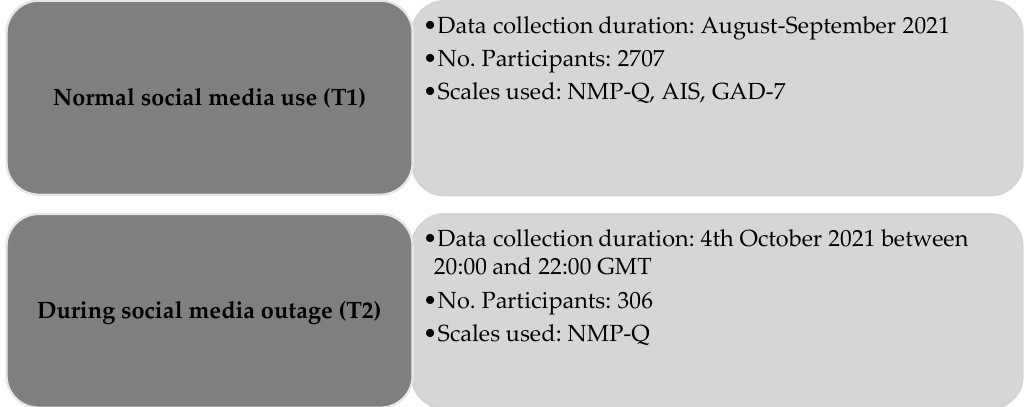
Figure 1 . Flow diagram of participants’ recruitment. Notes: NMP-Q = Nomophobia Questionnaire (NMP-Q); AIS = Athens Insomnia Scale, GAD-7 = General Anxiety Disorder-7.